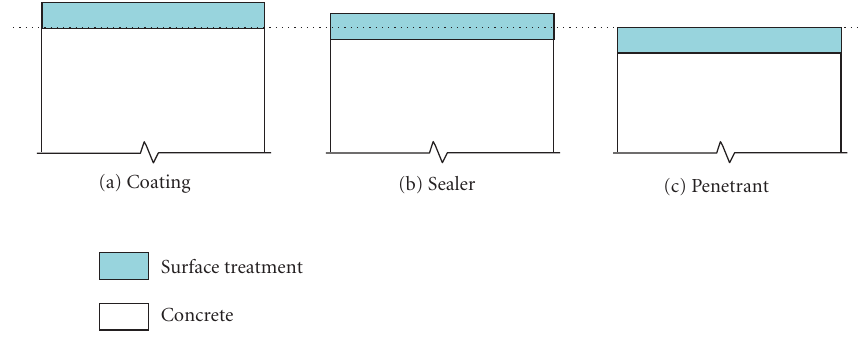
Figure 4: Type of surface treatment systems. Table 3: Mixing proportion of concrete.